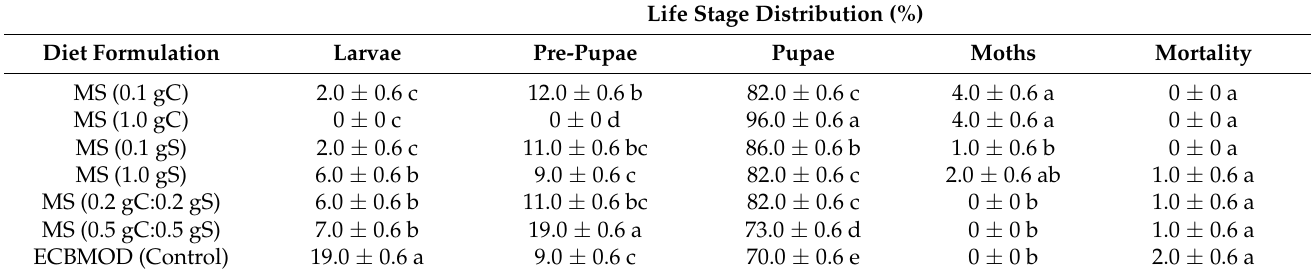
Table 5. Mean ( ± SE) distribution of Eldana saccharina life stages (percentage of larvae, pre-pupae, pupae, moths and total mortality) [ n = 170] recorded at the time of full pupal harvest (Day 27) on the MS (0.1 gC), MS (1.0 gC), MS (0.1 gS), MS (1.0 gS), MS (0.2 gC:0.2 gS), MS (0.5 gC:0.5 gS) and ECBMOD control diets. Means within columns with different lower-case letters indicate significant differences ( p < 0.05).